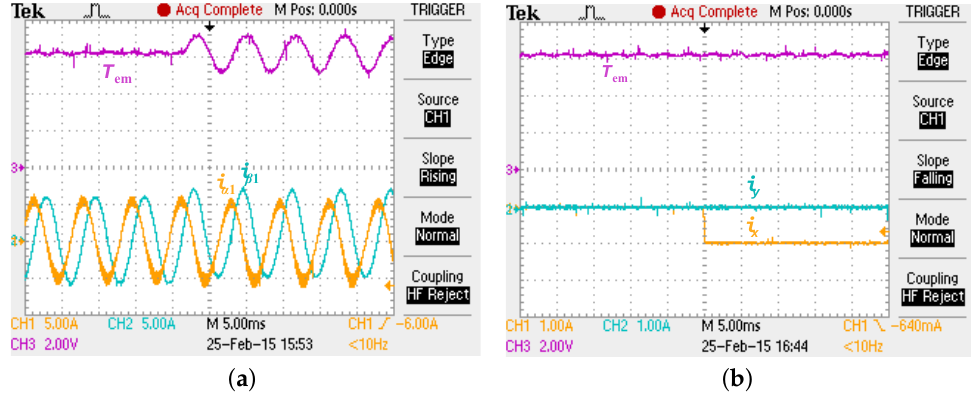
Figure 38. Effect of injecting dc current (for temperature estimation) on the electromagnetic torque T em , depending on whether it is added in the ( a ) α 1 - β 1 plane (as for n = 3) or ( b ) x - y plane, for a six-phase PMSM with asymmetrical WSA